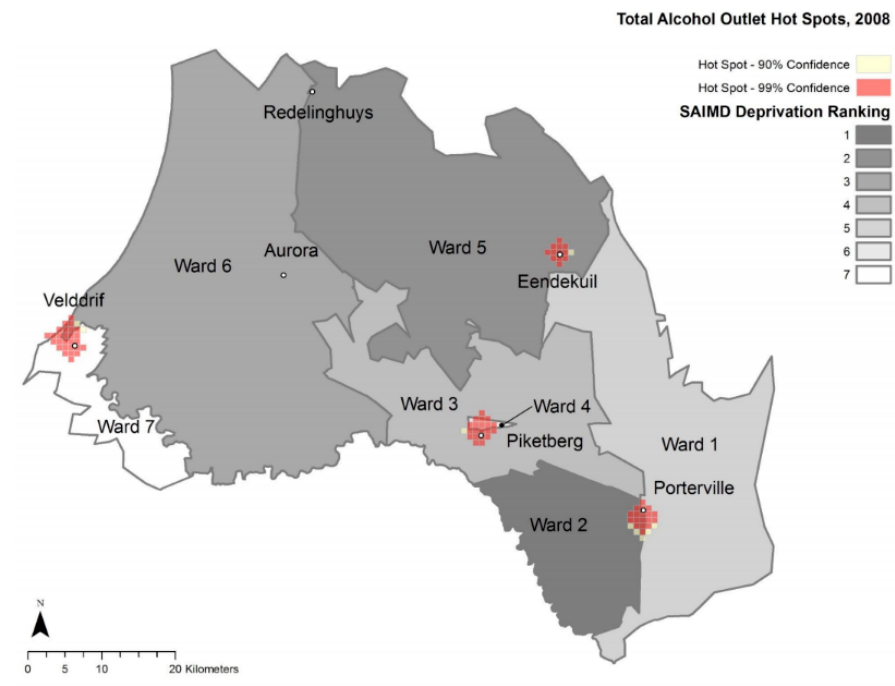
Figure 3. Total Alcohol Outlet Hot Spots, 2008 and Ward Deprivation.